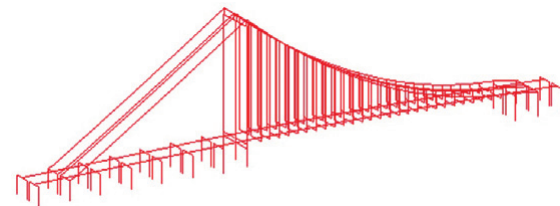
Fig. 3. 3-D finite element model of the Pingsheng